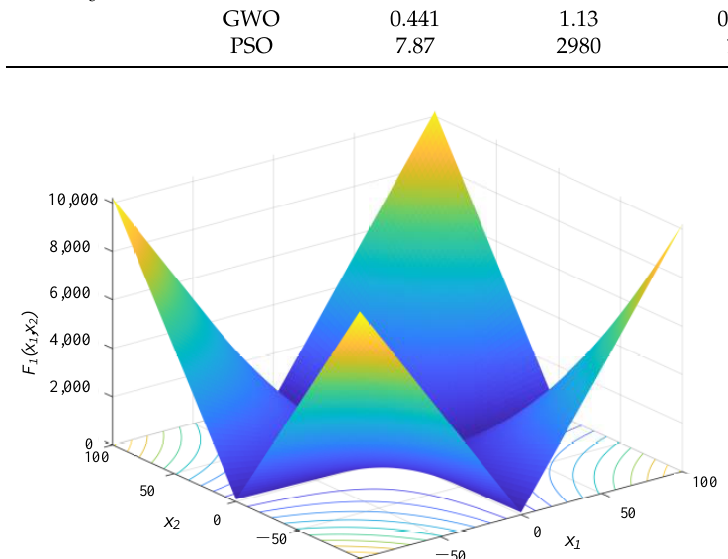
Figure 7. Testing function F 1 ( x ).